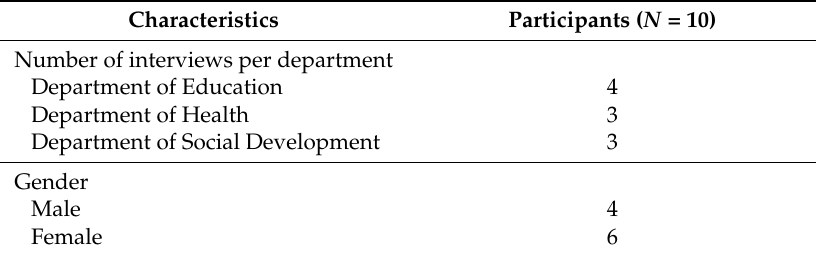
Table 1. Characteristics of study